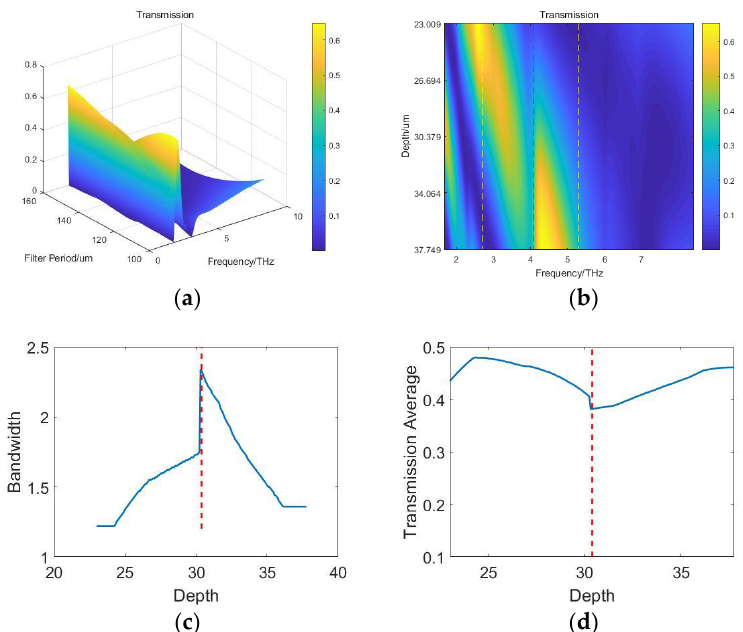
Figure 5. Effect of groove depth variation on filter performance: ( a ) and ( b ) show the effect diagram and the filter transmission spectrum; ( c ) and ( d ) are graphs of the 3-dB bandwidth and the average transmission efficiency with different groove